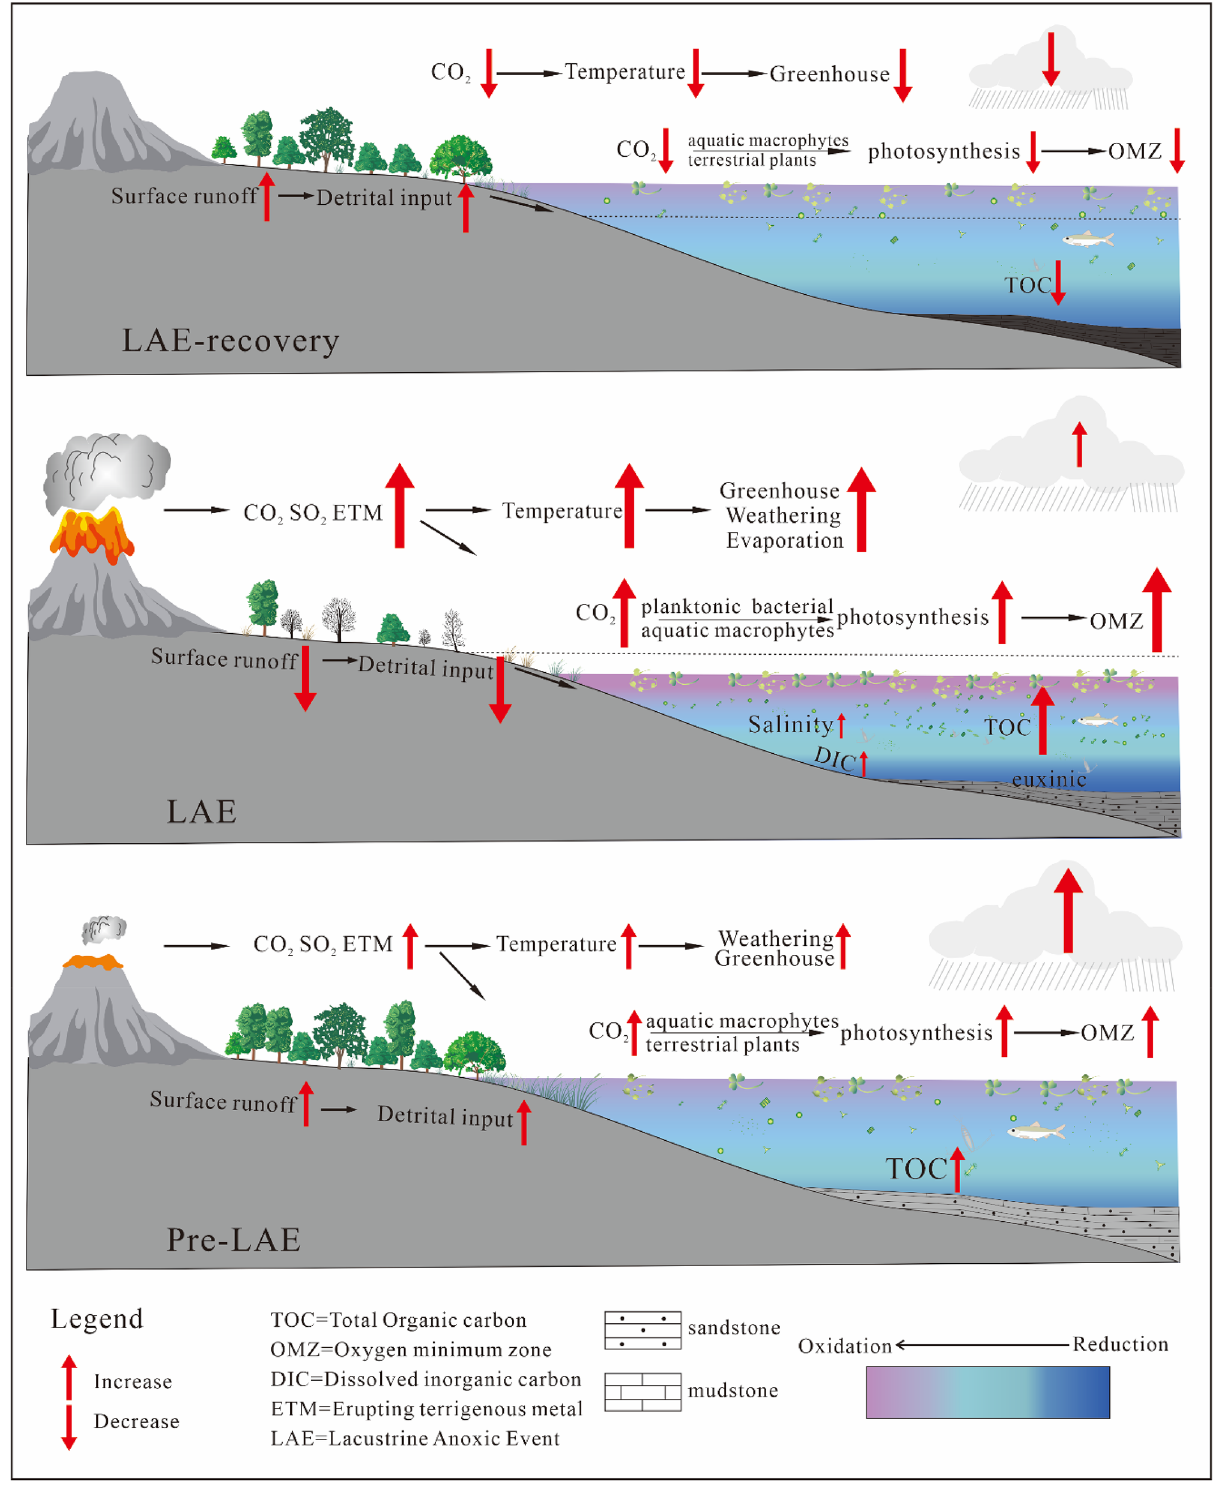
Figure 10. Change model of the different sediment stages (Pre-LAE, LAE, and LAE-recovery) of the continental lake under the influence of the OAE1a period (Drawn by Daijun Fan and Yibo